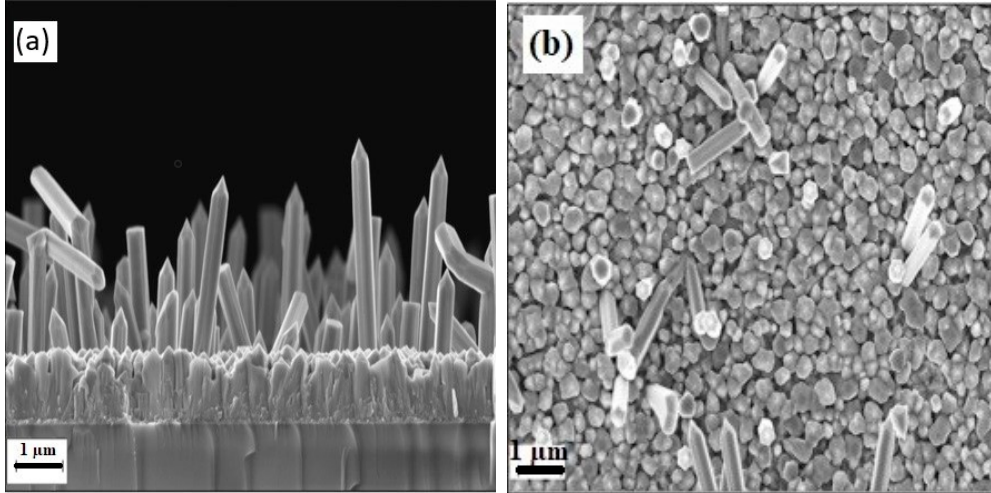
Figure 6. ( a ) Cross-section SEM image of nearly perpendicular ZnO NWs arrays grown on ZnO SL/Glass/ITO substrates at 5 mTorr, ( b ) top view SEM image of the as-grown ZnO NWs.